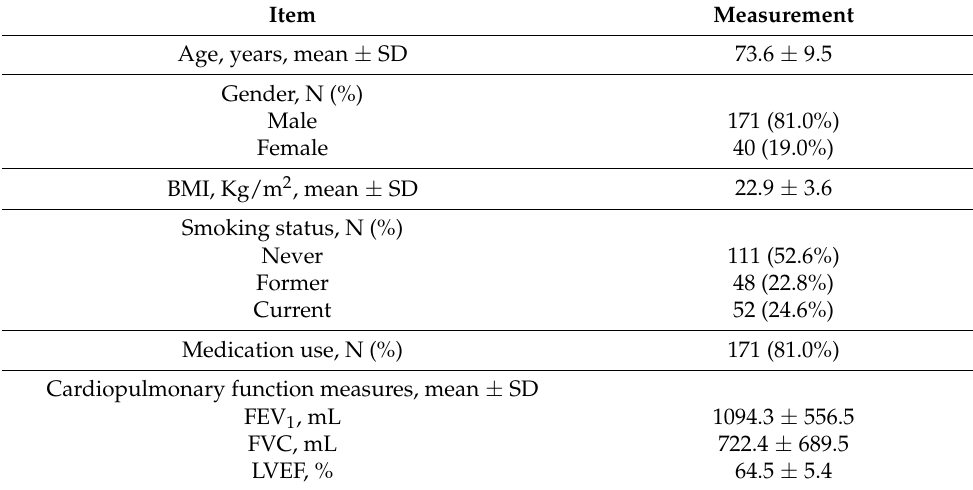
Table 1. Basic characteristics of the participants (N = 211). Item Measurement Age, years, mean ± SD 73.6 ±